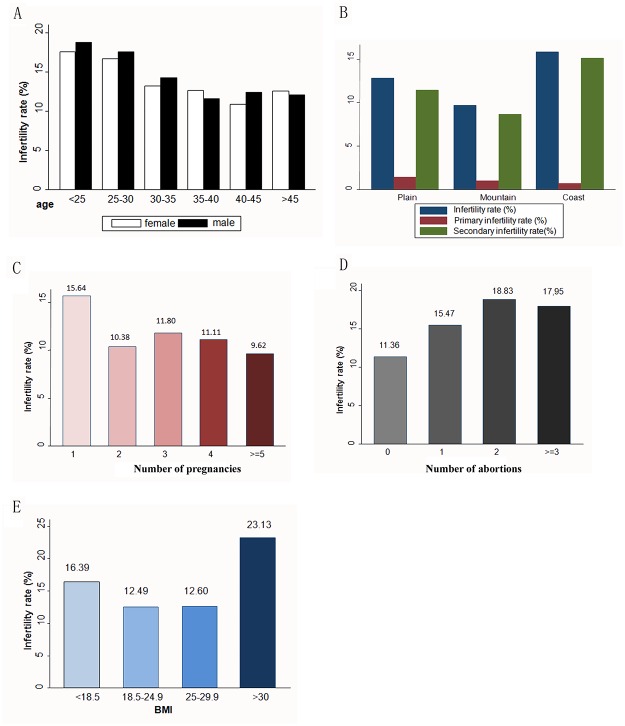
A) Age and infertility incidence: Male and female infertility incidences for all age groups are shown in this figure. Overall, both male and female age contribute to the incidence of infertility positively. B) Terrain and infertility incidence: Infertility incidences among couples living in different terrains vary significantly, especially for the secondary infertility incidence. The highest incidence of infertility occurred in those who live in coastal areas, followed by those who live plains and mountainous areas. C) Number of pregnancies and infertility incidence: With the increase in the number of pregnancies, we observed a concomitant drop of the infertility incidence. D) Number of abortions and infertility incidence: The increase in the number of abortions correlated with the incidence of infertility positively. E) BMI and infertility incidence: Incidence of infertility is lower in relatively moderate women BMI group, women with both underweight and obese will suffer high infertility incidence.